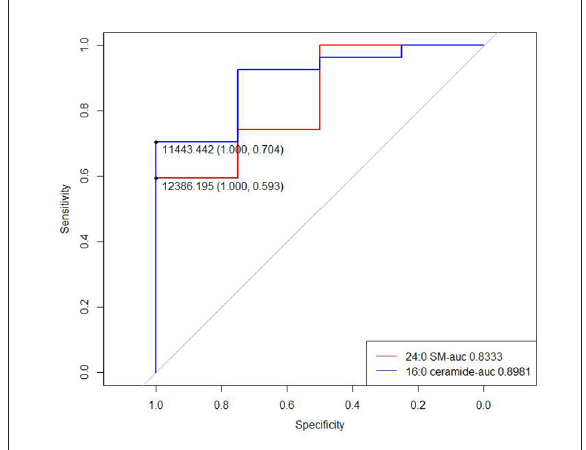
FIGURE6 ROC curves of 24:0 SM and 16:0 ceramide for predicting fatty infiltration grade.